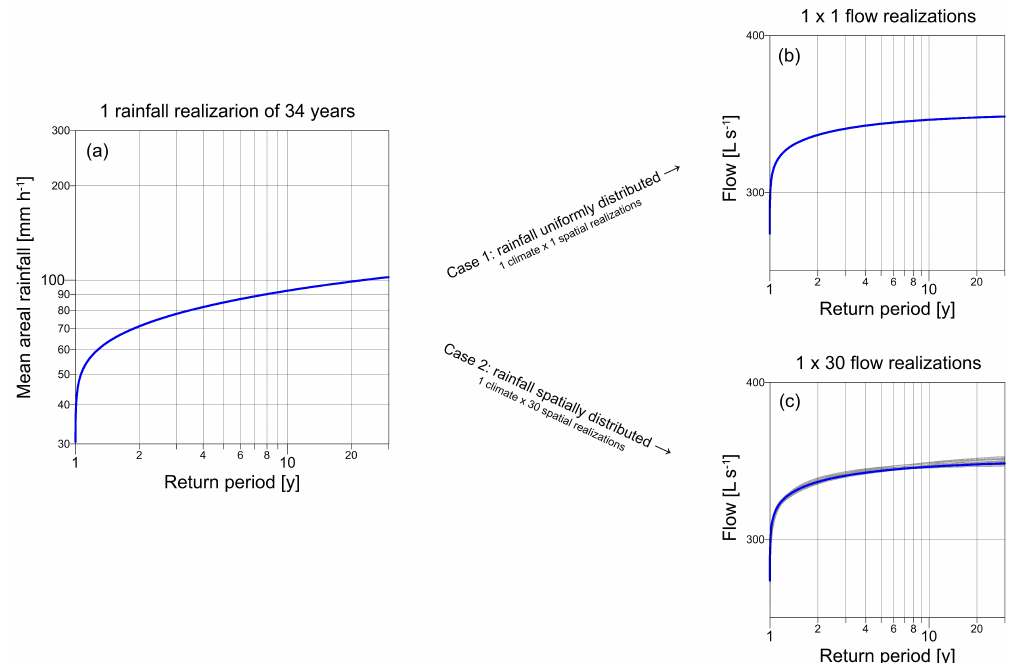
Figure 6. Rainfall and flow results for cases 1 and 2. In (a) , the IDF curve computed for the mean areal rainfall over the catchment is presented. In the right panels, FDF curves for location B are presented for uniformly distributed rainfall (b) and spatially distributed rainfall (c) . The blue line represents the IDF curve and the FDF curves computed from the observed uniformly distributed rainfall. Gray lines represent the FDF curves computed for the realizations with spatial rainfall variability.